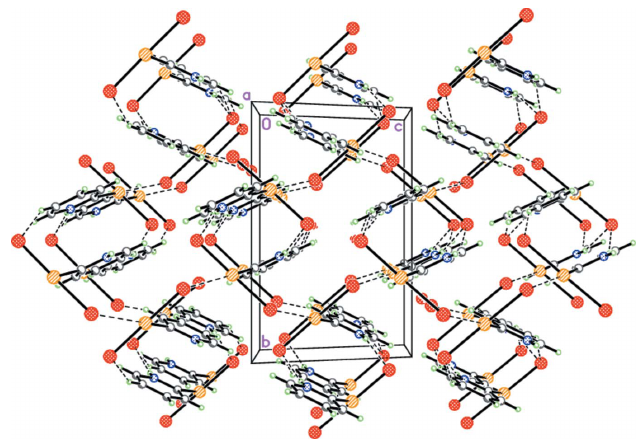
Figure 7 Crystal structure of 1 viewed along the a axis. Dashed lines indicate the intermolecular N—H (cid:3)(cid:3)(cid:3) Br and C—H (cid:3)(cid:3)(cid:3) Br hydrogen bonds as well as the non-covalent Se (cid:3)(cid:3)(cid:3) Br interactions.